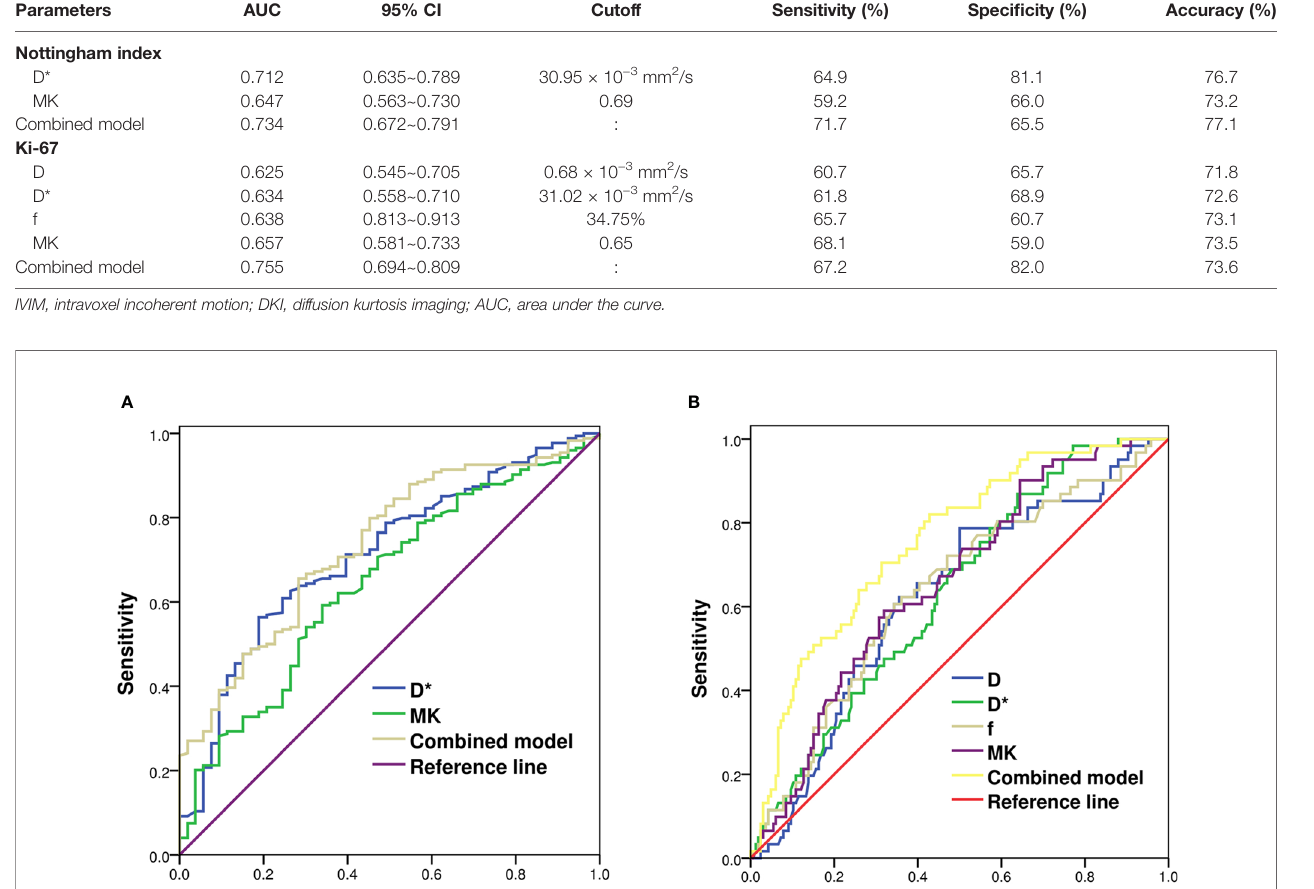
TABLE 3 | Diagnostic ef fi ciency of the IVIM and DKI models for predicting Nottingham index and Ki-67. Parameters